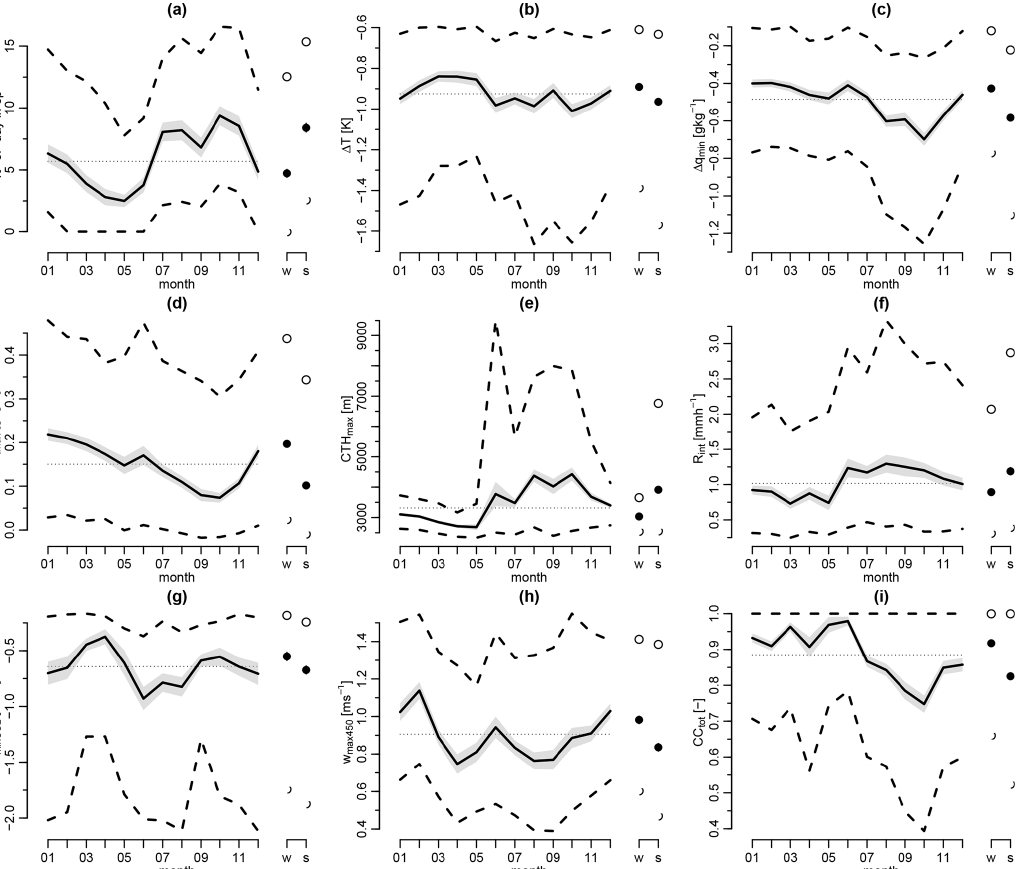
Figure B1. Monthly and seasonal distribution of important cold-pool diagnostics. (a) Daily cold-pool frequency, (b) (cid:49)T , (c) (cid:49)q min , (d) (cid:49)q max , (e) CTH max , (f) MRR R int , (g) w minSCL and (h) w max450 , and (i) CC tot . The lines represent the 25%, 50%, and 75% quar- tiles of the respective variables, the shading represents the median ± 1SE, and the points show the average distribution for the 5 winter (w; December–April) and summer months (s;